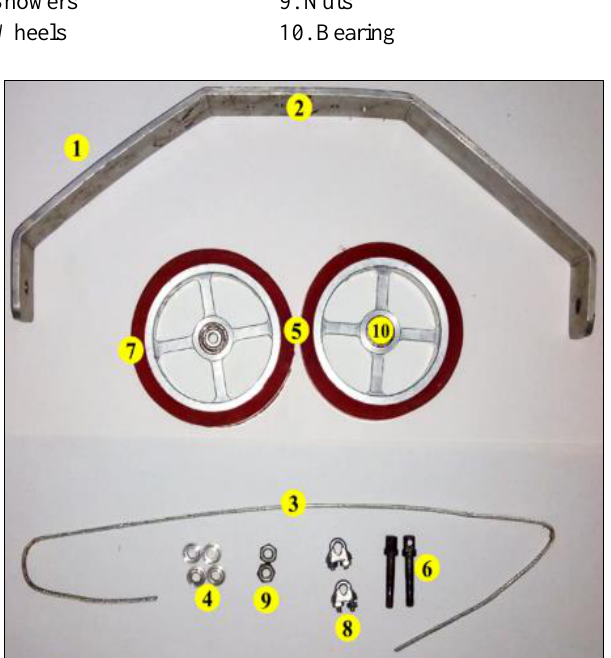
Figure 3: Classification of main landing gear